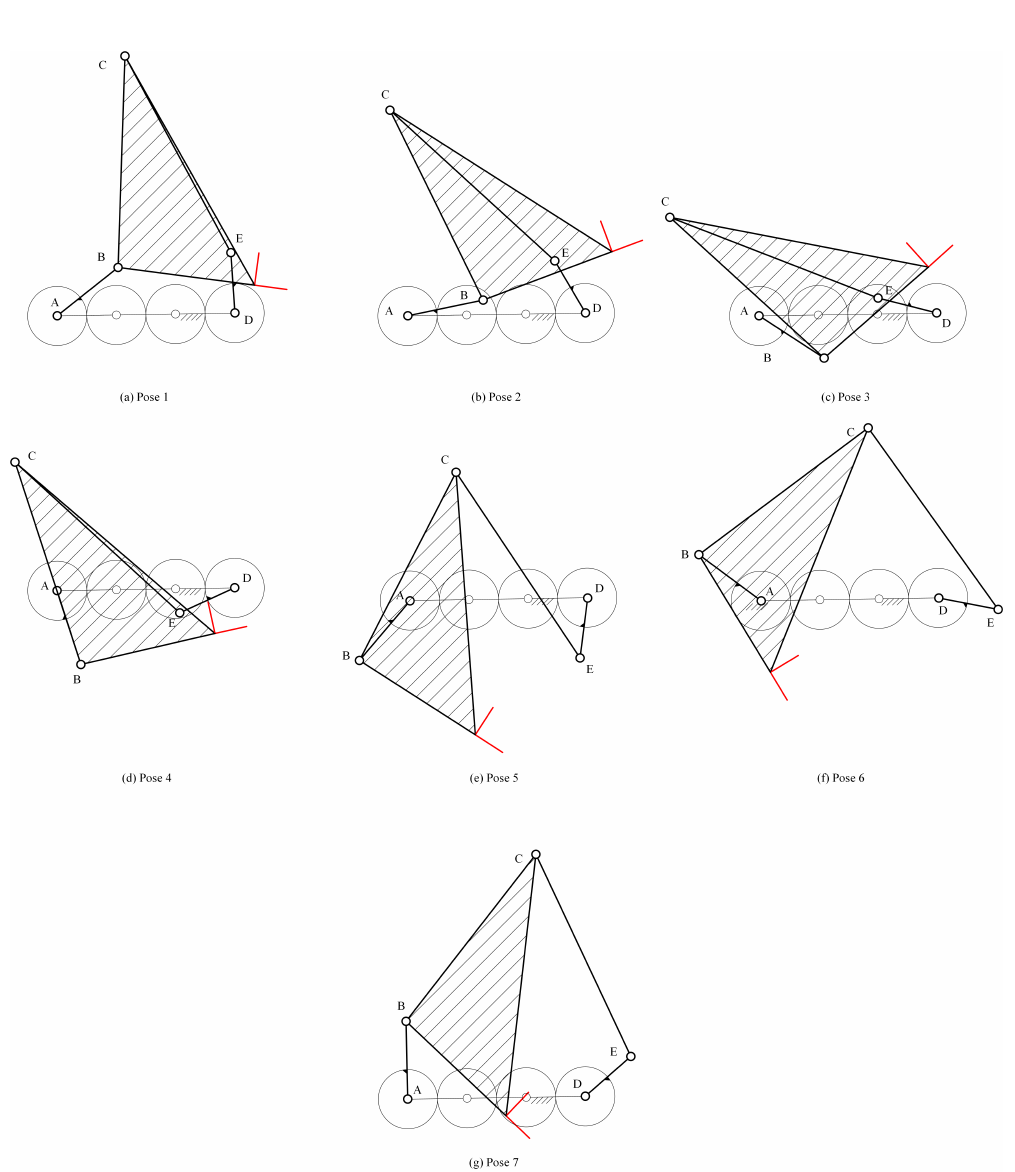
Figure 8. The solution geared five-bar mechanism at the seven precision poses.